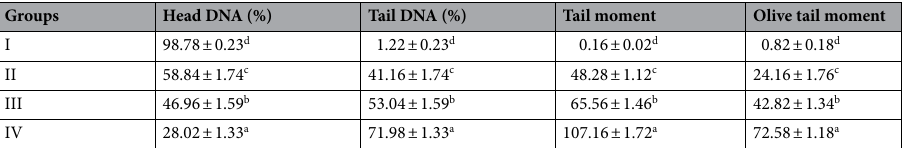
Table 4. Detection of DNA damage caused by Paraquat in leukocyte cells of Swiss albino mice. Group I: Control, Group II: 50 mg/kg b.w Paraquat, Group III: 100 mg/kg b.w Paraquat, Group IV: 200 mg/kg b.w Paraquat. Values are shown as mean ± SEM. Means shown with different letters on the same column are significantly different (p <